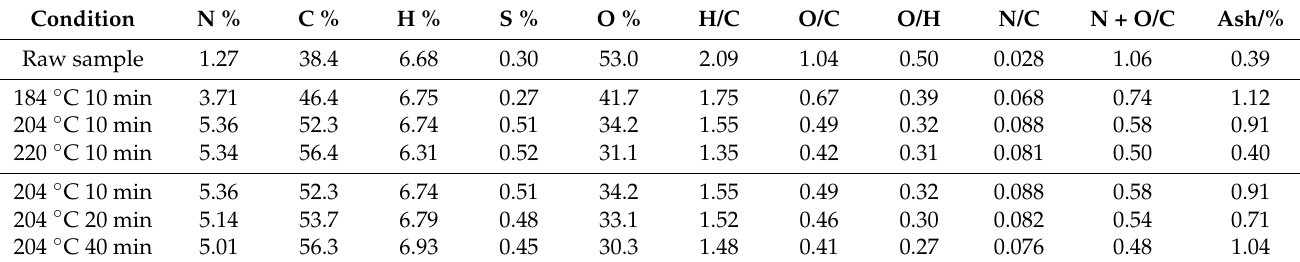
Table 3. Elemental composition and atomic ratios of HA S extracted from raw broccoli and SE broccoli. Condition N